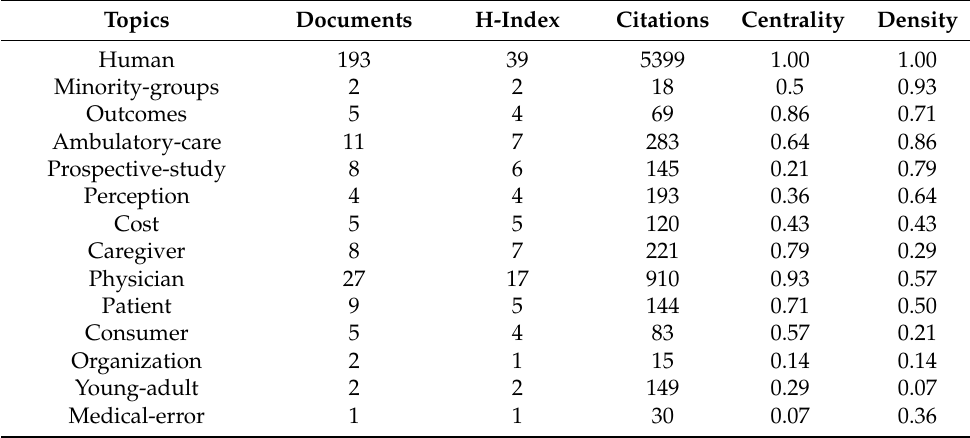
Figure 7. Strategic diagram of keywords based on documents-average citation from 2000–2010. Source: own elaboration. Table 8. The characteristic of the strategic diagram topics from 2000 to